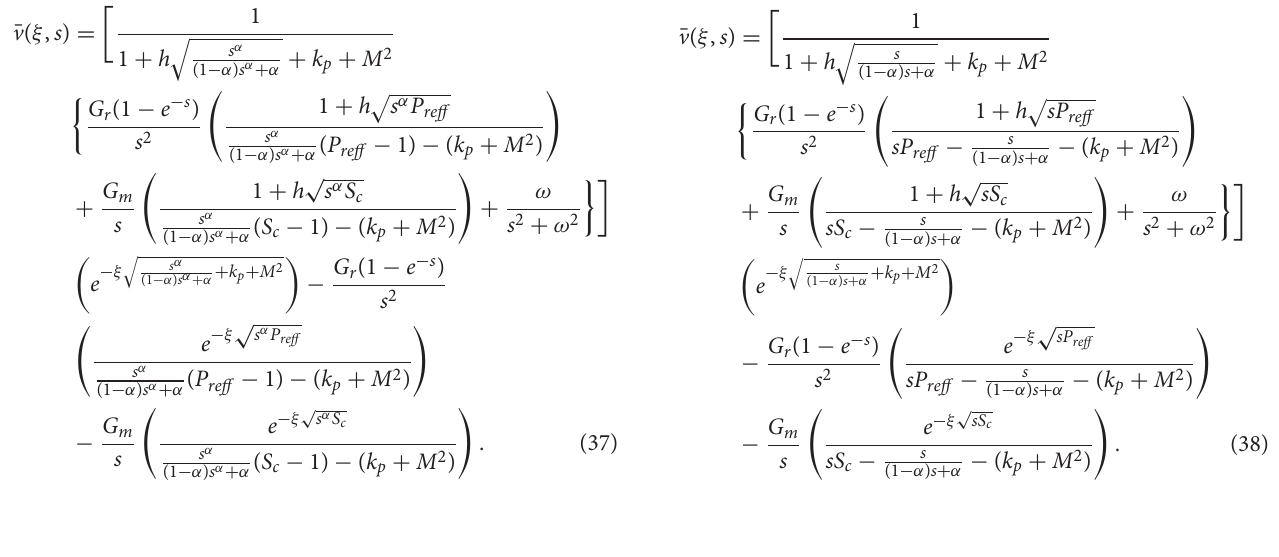
0.2, G r 2, P reff 0.1, G m 0.75, k p 1.5, S c 0.5, and M = = = = = =